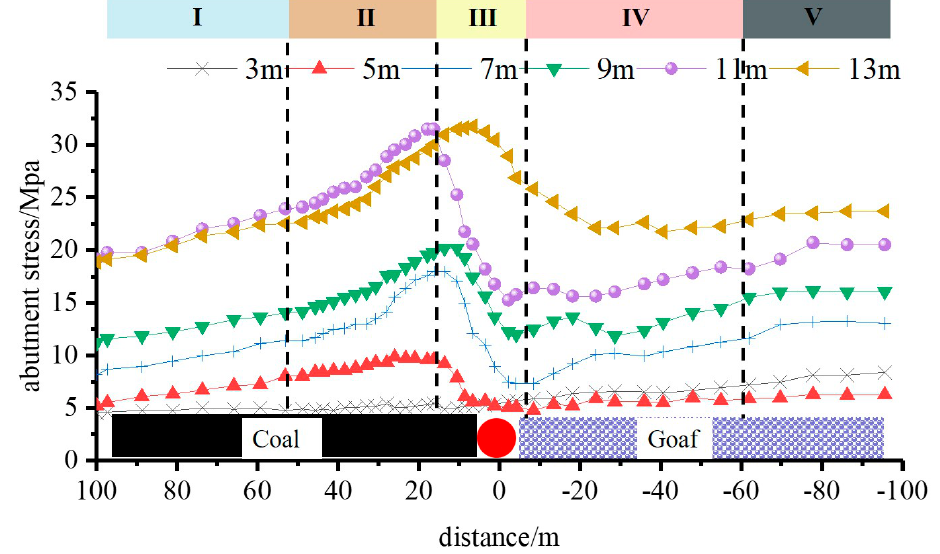
Figure 11. Strike abutment pressure curve of the roof-noncutting entry (head entry) of station 1#. The abutment pressure at the 3 m position of the station 1# rises the slowest, and the increasing trend is not obvious, which is likely that the coal mass in this range was yielded or even destroyed by the strong abutment pressure, so its bearing capacity is smaller. The variation tendencies of the strike abutment pressure at 5–13 m are the same, showing a state of increasing first, then decreasing and then increasing, and finally stabilizing. However, the speed and amplitude of the strike abutment pressure growth within the range of 100 to 20 m in front of the working face increases in turn with the increase of the coal depth.